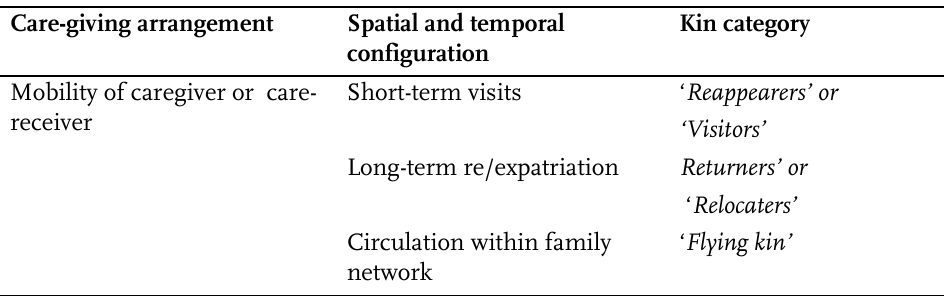
Table 1 : A typology of proximate care giving arrangements within transnational families Care-giving